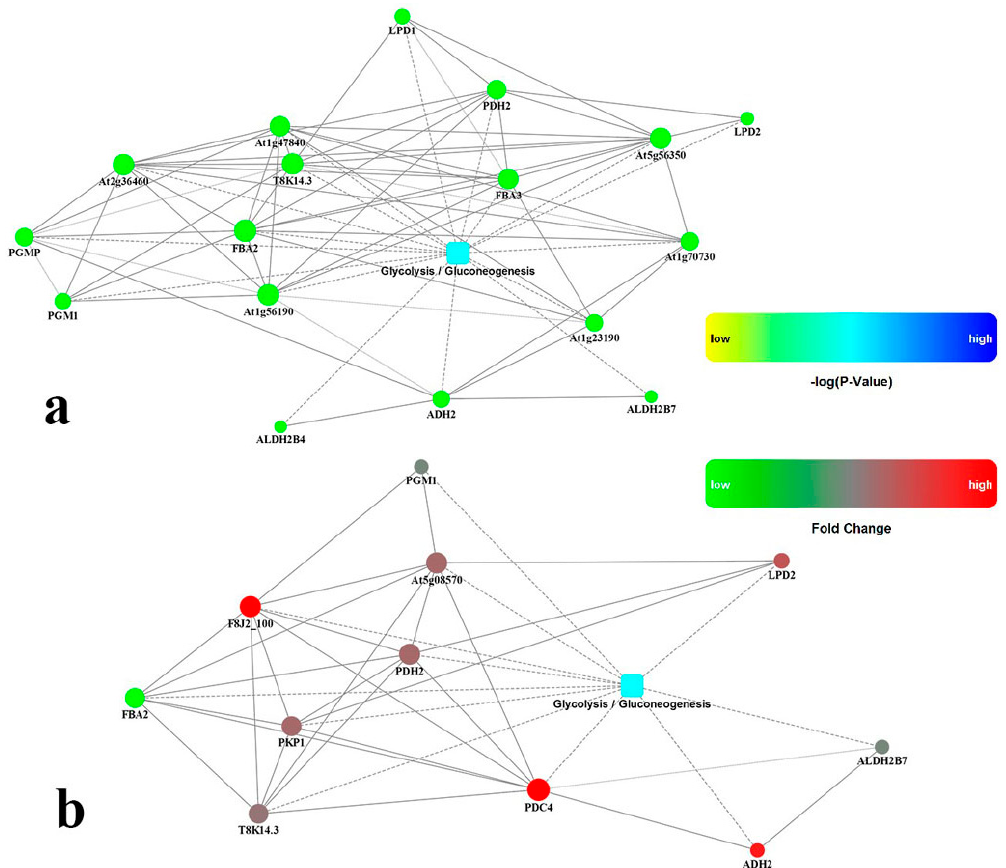
Figure 8. Regulatory changes in the pathway of glycolysis/gluconeogenesis. Colored circle nodes correspond with the ramie genes detected in the isobaric tags for relative and absolute quantitation (iTRAQ) data. ( a ) upregulated or downregulated genes in leaves; ( b ) upregulated or downregulated genes in roots. The above network model is generated with a cytoscape web application, based on information gained from up to four levels of functional analysis: fold change of gene/protein, protein-protein interaction, Kyoto Encyclopedia of Genes and Genomes (KEGG) pathway enrichment, and biological process enrichment. Circle nodes: genes/proteins; rectangle nodes: KEGG pathway or biological process. Pathways are colored in a gradient color from yellow to blue; yellow indicates a lower p -value, and blue indicates a higher p -value. Biological processes are colored in red. In the case of fold change analysis, genes/proteins are colored in red (upregulation) and green (downregulation). A default confidence cutoff of 400 was used: interactions with a higher confident score are shown as solid lines between genes/proteins; dashed lines indicate otherwise.